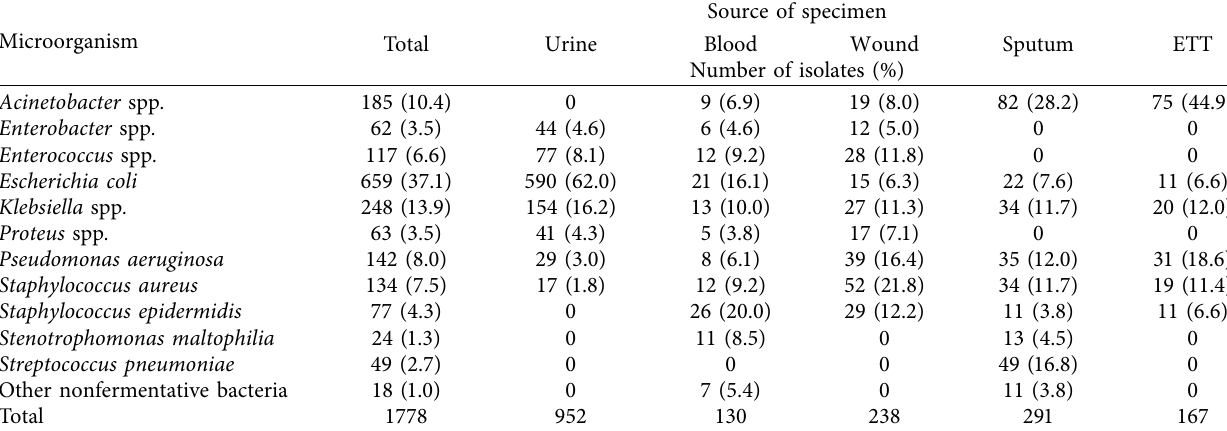
Number of isolates (%)